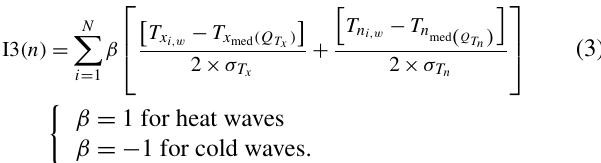
Table 1. Spatial mean (and standard deviation in parentheses) of to- tal number of days detected as hot days (larger than quantile 0.9, first column), over the entire period (21 years) of analysis, spatial mean of total days detected during heat waves (HW, with persis- tence longer than 3 days, second column) during the same period and spatial mean of total number of HW during the 21 years (third column) using only T min (first row), only T max (second row) and the intersection of the two variables ( T int , third row).